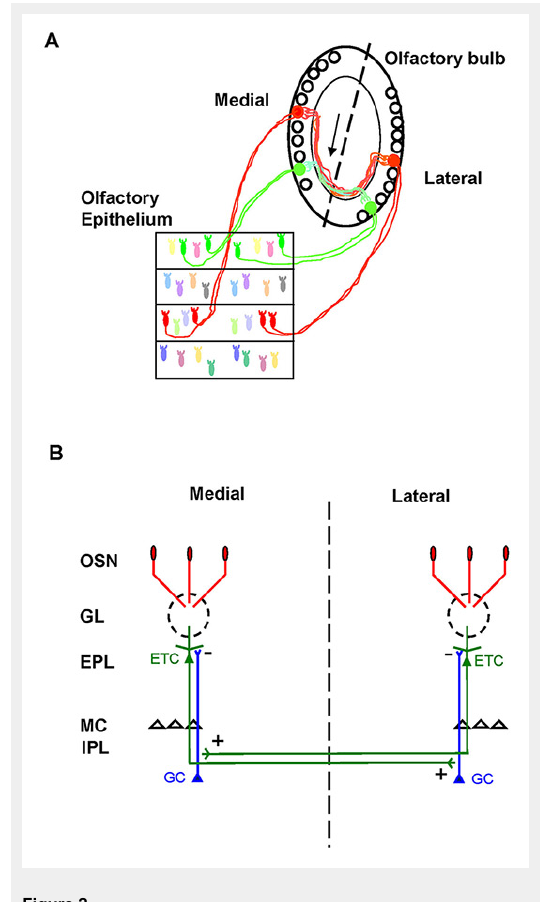
Schematic of neuronal wiring in the olfactory bulb. A. Olfactory sensory neurons (OSNs) expressing the same odorant receptor (green and red) converge to form glomeruli on the medial and on the lateral side of each olfactory bulb (OB). Glomeruli receiving axons expressing the same odorant receptor (OR) (i.e. homologous glomeruli) are specifically and reciprocally connected by the intrabulbar link, related to external tufted cells (arrow). Dashed line indicates the line of symmetry between the two mirror-symmetric maps in horizontal sections (Lodovichi et al., 2003 [27]). B. Schematic of the intrabulbar connections between homologous glomeruli. Briefly, external tufted cells (ETC) connected to a given glomerulus form an axonal projection in the internal plexiform layer (IPL) precisely underneath the homologous glomerulus, on the opposite side of the OB. In the IPL, ETC form excitatory synapses with the granule cells, the major inhibitory interneurons in the OB. This connection is reciprocal. EPL = external plexiform layer; GC = granule cells; GL = glomeruli; MC = mitral